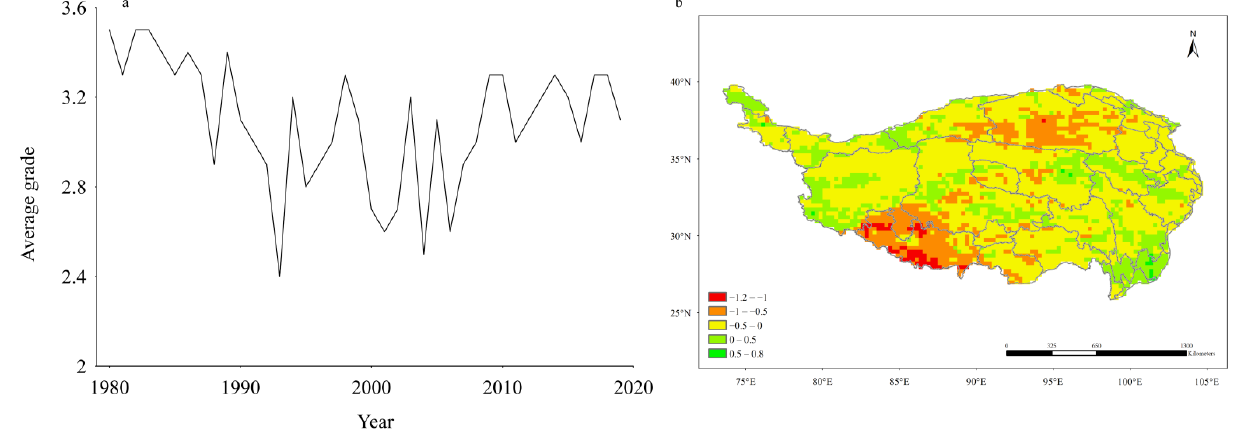
Figure 4. Regional average grades of snow disasters ( a ) and spatial distribution of the long-term variations ( b ).